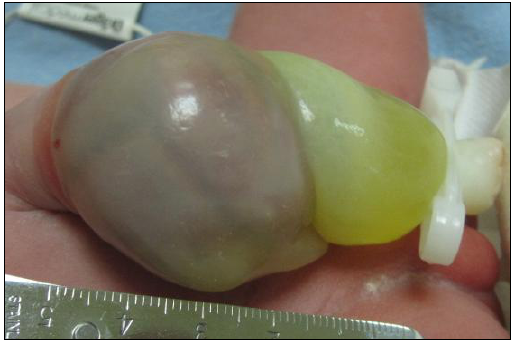
Figure 1: Omphalocele sac.